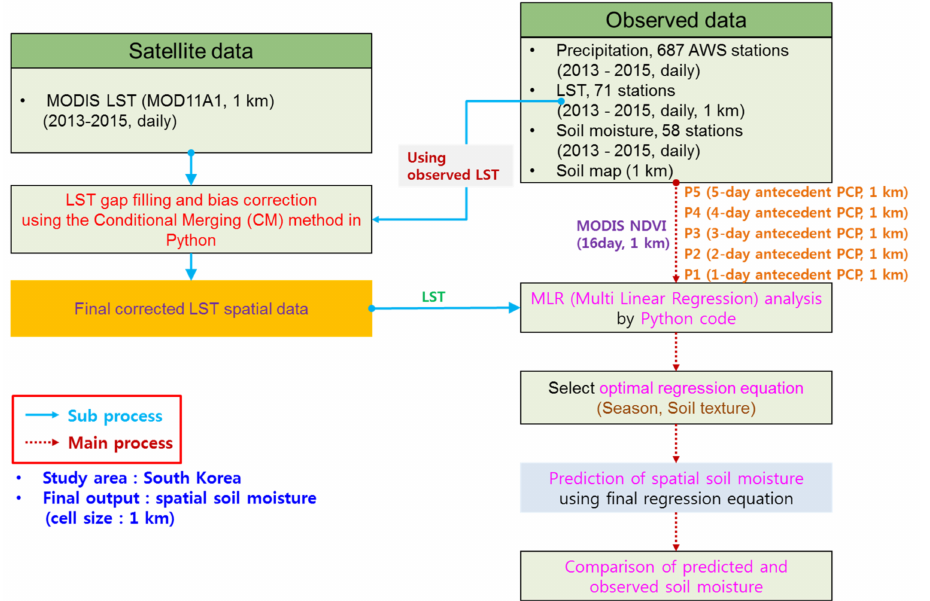
Figure 1. Flow chart of the study. For the satellite data, MODIS is the Terra moderate-resolution imaging spectroradiometer.